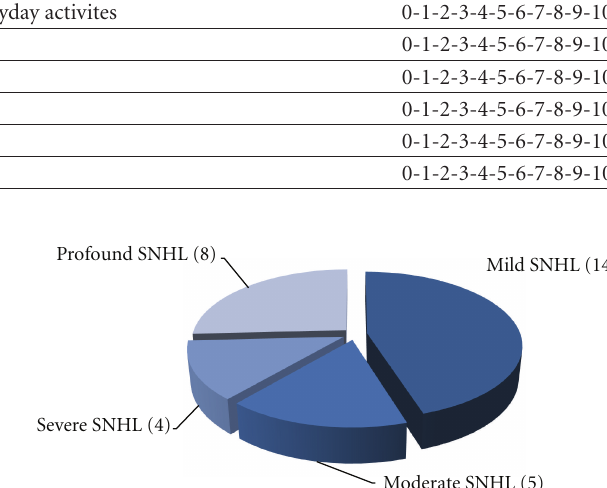
Table 2: The questionnaire that was used to estimate results of treatment. Measure the following parameters using visual analog scale (VAS):